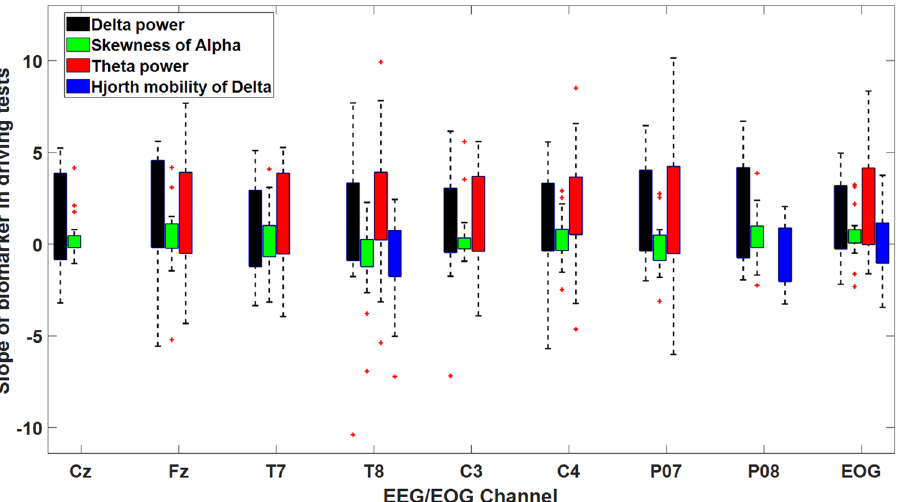
Figure 7. Representation of the slope of the biomarkers in the driving tests. The average values of the Delta and Theta powers of EEG channels are positively correlated with PERCLOS in all of the driving